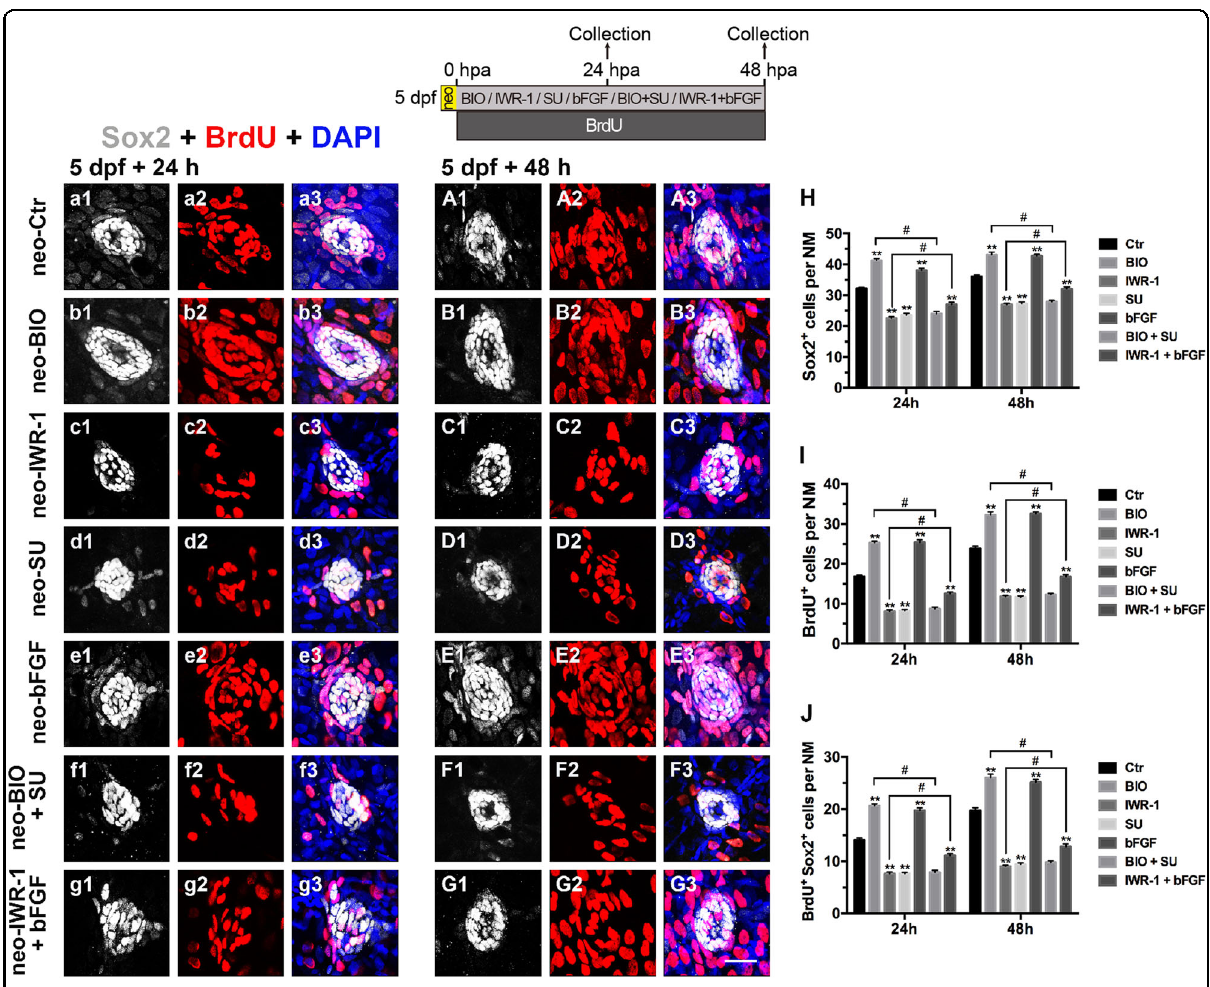
Fig. 8 Effects of exogenous regulation of the Wnt and FGF pathways on regenerative proliferation at 24 hpa and 48 hpa after neomycin injury. a1 – G3 : Regenerating cells labeled with BrdU (red) and SCs labeled with Sox2 (white). a1 – a3 : 24 hpa after neomycin damage; A1 – A3 : 48 hpa after neomycin damage; b1 – b3 : 24 hpa after addition of BIO, an activator of the Wnt pathway; B1 – B3 : 48 hpa after addition of BIO; c1 – c3 : 24 hpa after addition of IWR-1, an inhibitor of the Wnt pathway; C 1 – C3 : 48 hpa after addition of IWR-1; d1 – d3 : 24 hpa after addition of SU5402, an inhibitor of the FGF pathway; D1 – D3 : 48 hpa after addition of SU5402; e1 – e3 : 24 hpa after addition of bFGF, an activator of the FGF pathway; E1 – E3 : 48 hpa after addition of bFGF; f1 – f3 : 24 hpa after addition of BIO and SU5402; F1 – F3 : 48 hpa after addition of BIO and SU5402; g1 – g3 : 24 hpa after addition of IWR-1 and bFGF; G1 – G3 : 48 hpa after addition of IWR-1 and bFGF. h – j : Quanti fi cation of the supporting cells (Sox2 + ) ( h ), proliferative cells (BrdU + ) ( i ) and regenerating supporting cells (BrdU + Sox2 + ) ( j ) after blocking or enhancing the Wnt and FGF pathways. n = 7 fi sh per group. ** Indicates p < 0.001, # indicates p < 0.05, and error bars indicate the standard error of the mean. Scale bar in G3 = 20 μ m for a1 –